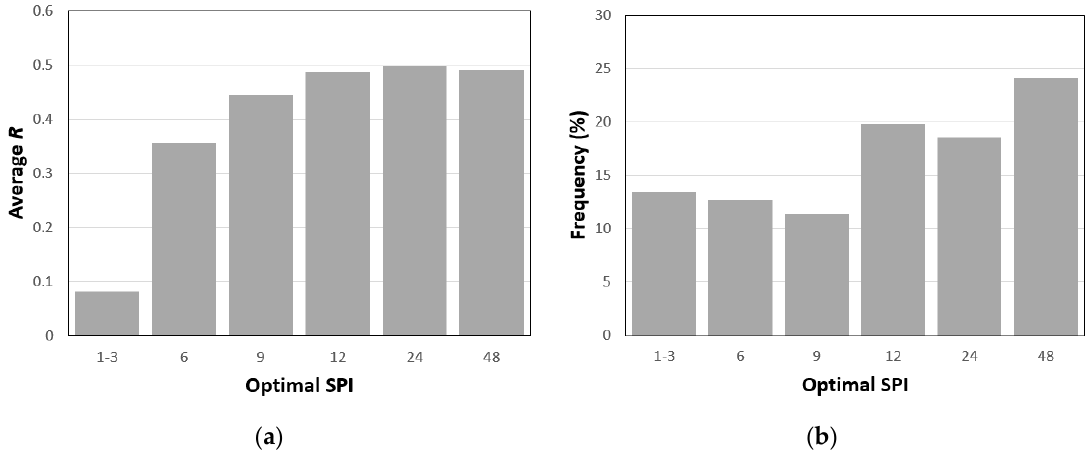
Figure 5. Statistics of the optimal SPI. ( a ) Average R values for all the cells with the same local-optimal SPI value. ( b ) Frequency distribution of the local-optimal SPI values at the global scale.